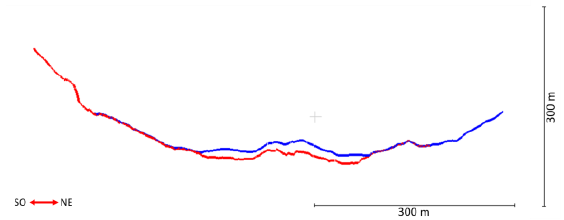
Figure 14. Comparison between 2014 DPCs (in blue) and 2016 DPC (in red) along Section 2.